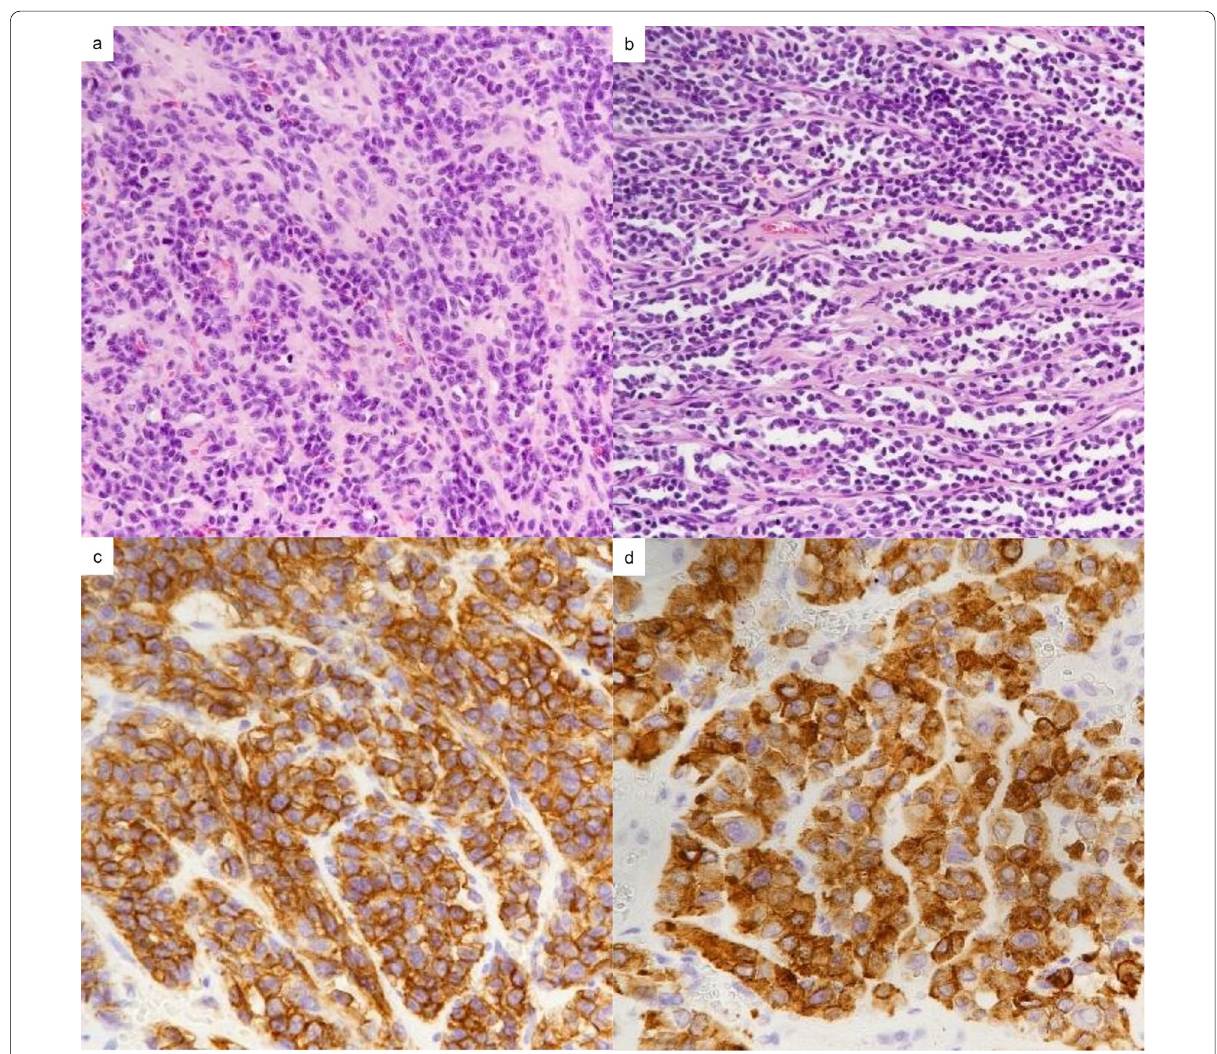
Fig. 2 Microscopic findings of neuroendocrine composite hemangioendothelioma. a The epithelioid portion of the tumor was consisted of a sheet-like proliferation of uniform, small, epithelioid endothelial cells (H&E, branching vascular channels lined by monotonous, hobnailing endothelial cells (H&E, hemangioendothelioma. The tumor cells showed diffuse and strong immunoreactivity for CD31 ( c ;